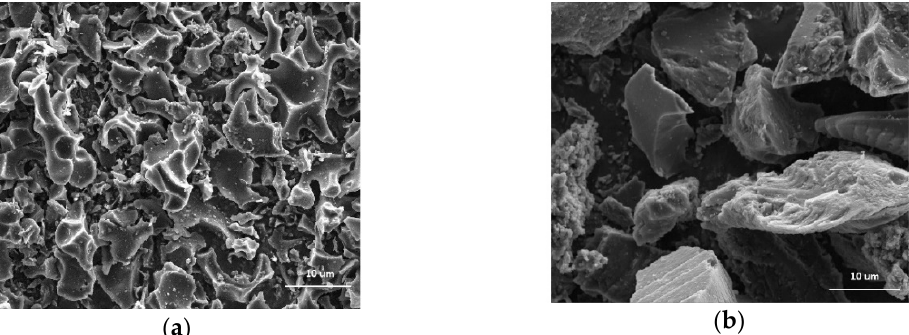
Figure 1. The microstructure of activated carbons prepared by chemical activation of olive stones with ( a ) potassium hydroxide (CK) and ( b ) phosphoric acid (CP); estimated by SEM analysis. Table 1. Chemical composition of activated carbons prepared by chemical activation of olive stones with potassium hydroxide (CK) and phosphoric acid (CP); estimated by XPS analysis. Sample C